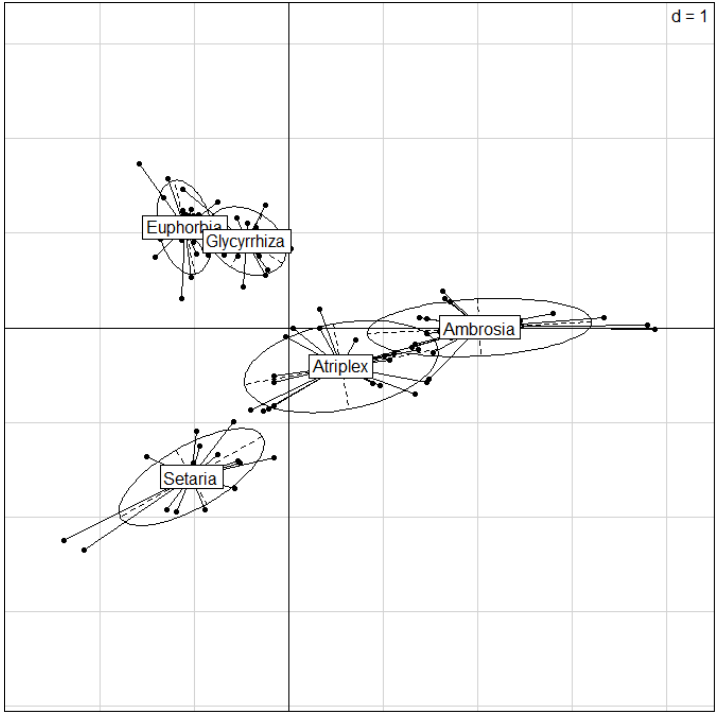
Figure 13. Projection of CI, D1, Datt3 values for Ambrosia artemisiifolia , Atriplex tatarica , Glycyrrhiza glabra , Euphorbia seguieriana , and Setaria pumila . Table 9. The value of the dispersion of the principal components of the projection CI, D1, Datt3 Ambrosia artemisiifolia , Atriplex tatarica , Glycyrrhiza glabra , Euphorbia seguieriana , and Setaria pumila.